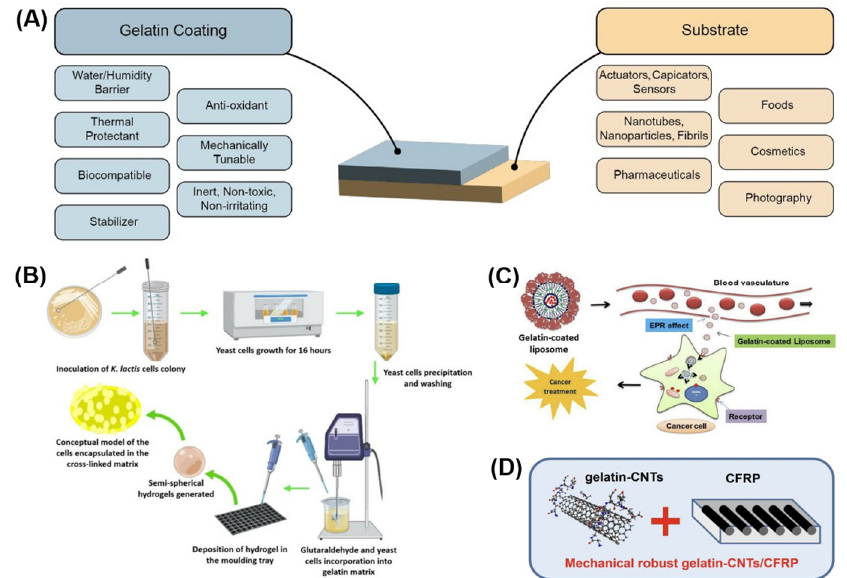
Figure 8. Gelatin used for actuator coatings. ( A ) Schematic depicting the benefits of gelatin-based coatings and their applications. ( B ) The protocol followed for the encapsulation of probiotic cells in the gelatin-glutaraldehyde (GTA) matrix [138]. ( C ) Summary of the cellular uptake of gelatin-coated liposomes [7]. ( D ) Mechanical robust gelatin-CNTs/CFRP composite [139]. (Images ( B – D ) are licensed under CC BY 4.0 (http://creativecommons.org/licenses/by/4.0/ (accessed on 30 October 2022))). Wei et al., used gelatin methacryloyl (GelMA) to develop a biodegradable